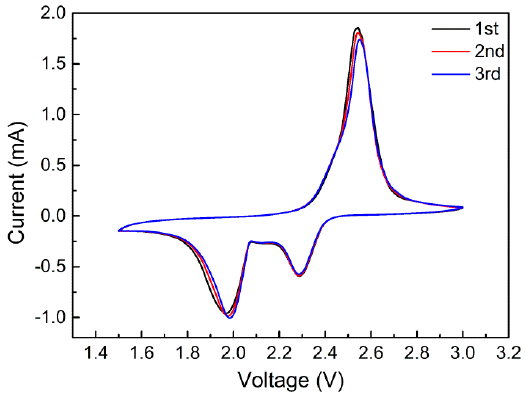
Figure 6. Cyclic voltammograms of the cells with CNTs-coated separator.